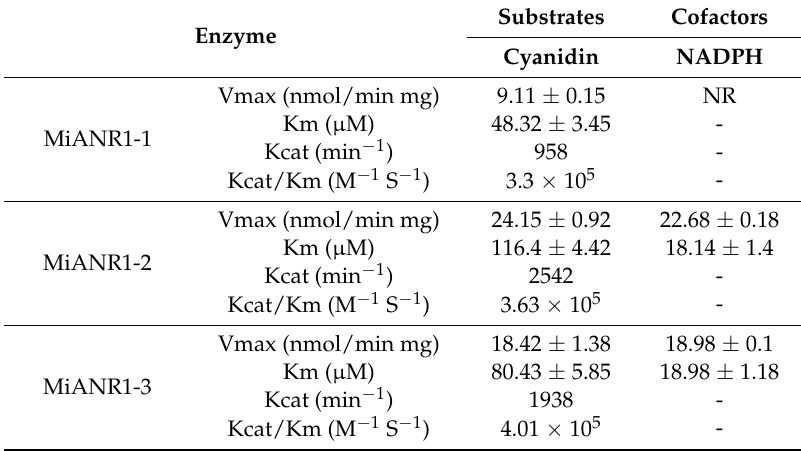
Table 1. Kinetic properties of Mi ANR1-1, 1-2and 1-3.